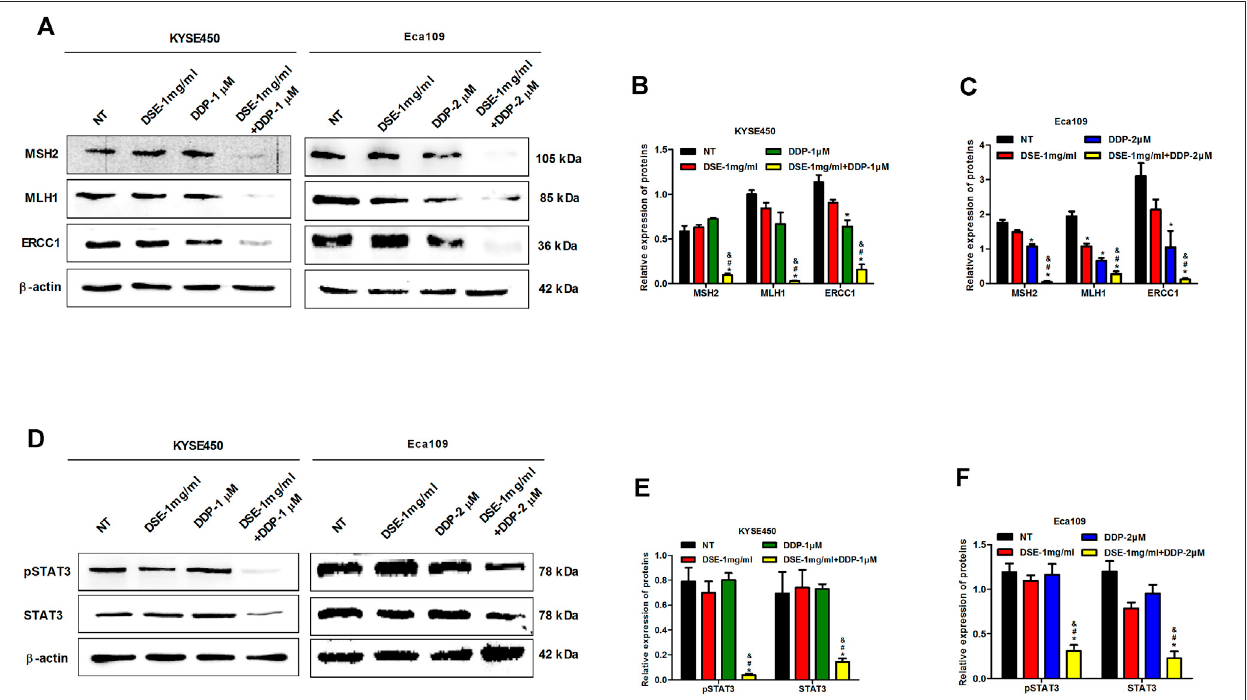
FIGURE 10 | DSE promotes DNA damage and inhibits phosphorylation of STAT3. (A – C) Effects of the combination of DSE and DDP on the expression of DNA repair-related proteins MSH2, MLH1 and ERCC1 in KYSE450 and Eca109 cells. (D – F) Effects of the combination of DSE and DDP on the expression of STAT3 and pSTAT3inKYSE450andEca109cells.Alldataareexpressedasmean±standarddeviation( n =3).* p < 0.05vs.NTgroup.# p < 0.05vs.DSEgroup. & p < 0.05vs.DDP group. NT: No